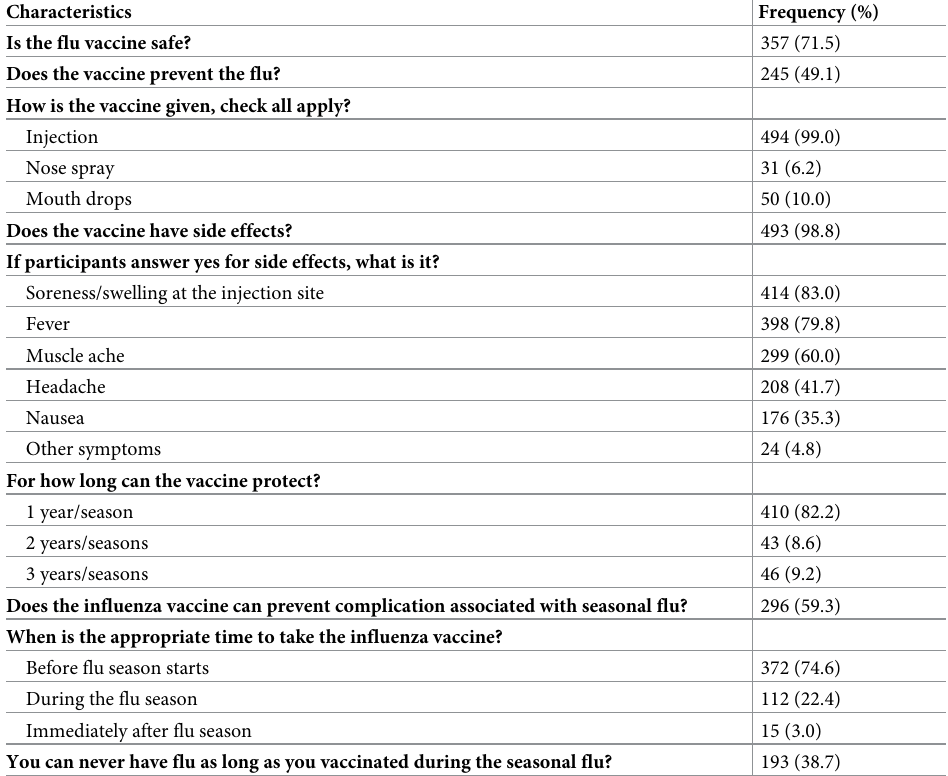
Table 3. Participants’ knowledge regarding flu vaccine (N = 499).